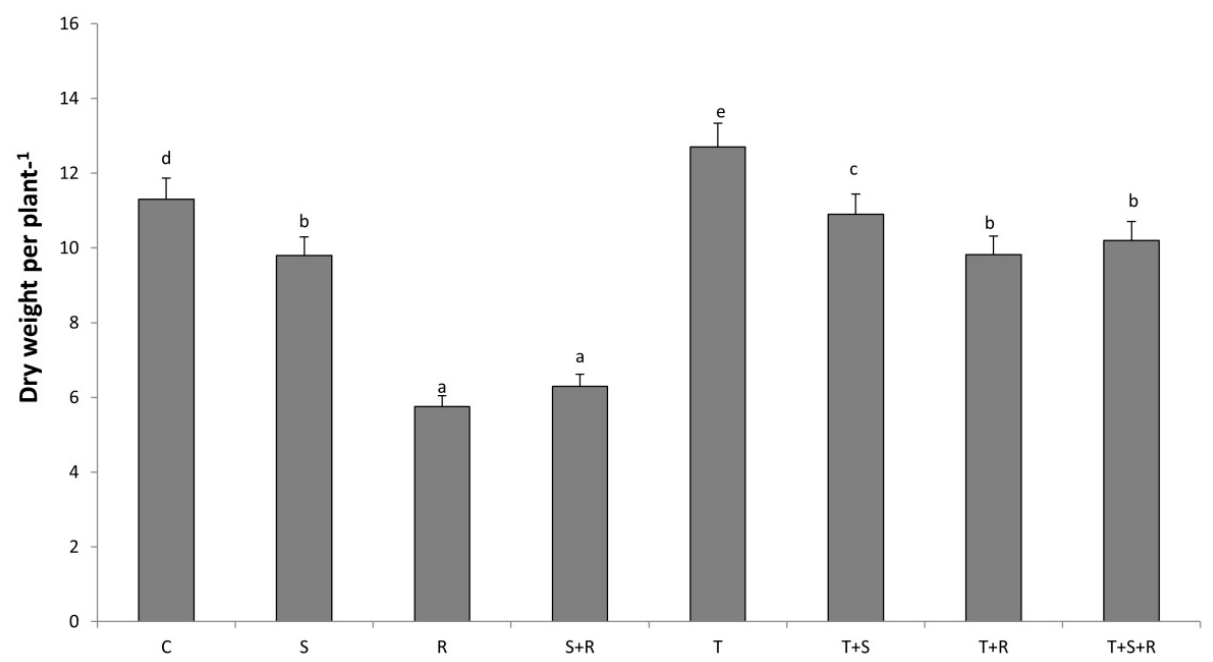
Figure 3. The effect of T. citrinoviride on leaf dry weight of strawberry plants which were subjected to abiotic stress (40 mM NaCl) and biotic stress ( R. solani ) either separately or in combination. Different letters indicate significant differences between the treatments (( p < 0.05). C, control; S, NaCl-treated; R, R. solani -infected ; S + R, Salt stress + R. solani; T, T. citrinoviride- treated; T + S, T. citrinoviride + NaCl; T + R, T. citrinoviride + R. solani ; T + S + R, T. citrinoviride + NaCl + R. solani. Table 1. Results of multiple comparisons by ANOVA for Trichoderma (T), Salt (S), Rhizoctonia (R), control (C) and their interactions for dry weight, Fv/Fm, H 2 O 2 , TBARS, NOX, SOD, POX, CWPOX values. Multivariate analysis through general linear model (GLM) was performed using the LDS